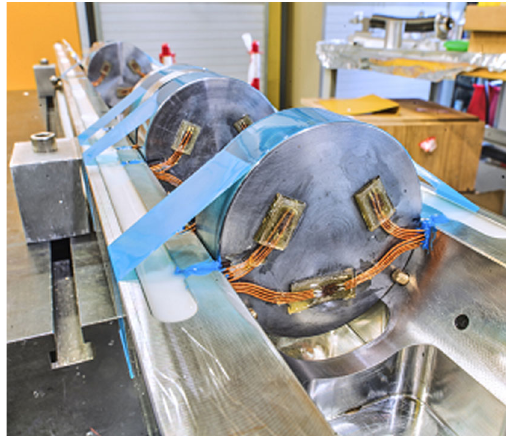
FIG. 13. Instrumented prototype blocks installed on the inner tank lower half shell. The three biaxial strain gauges at 120° covered by the protective agent can be observed